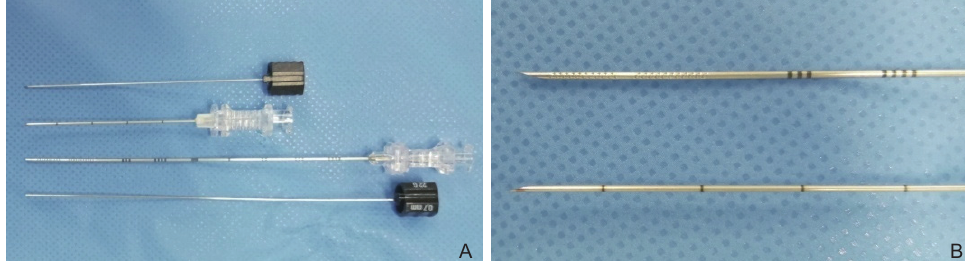
Figure 1 Puncture needles for thyroid nodule FNA. (A) 22 G core needle;(B) The scale marks on the needle shaft can indicate the depth of the needle tip inserting the human body, and the front section of the puncture needle is specially processed to enhance ultrasonic reflection.